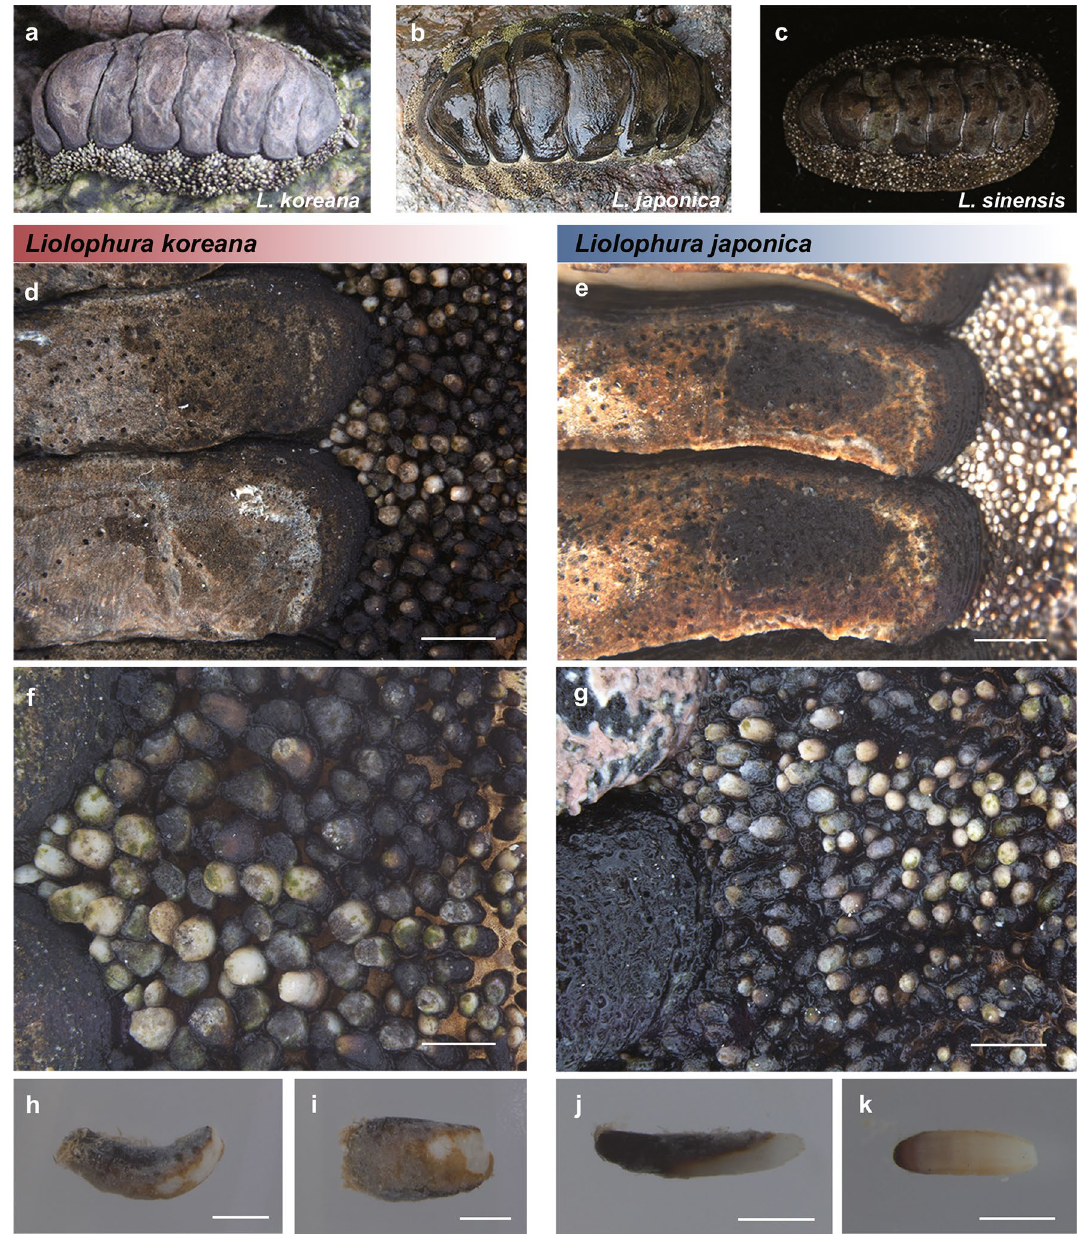
Figure 5. Morphological comparison of Liolophura koreana , sp. nov., L. japonica , and L . sinensis , sp. nov. (a–c) Photos of dorsal views of the individuals belonging to L . koreana (Lineage N), L . japonica (Lineage S1), and L . sinensis (Lineage S2) in order. (d,e) Morphological comparison of pleural and lateral black spots on valves III and IV of the tegmentum of L . koreana (d; holotype) and L . japonica ( e ). (f,g) Morphological comparison of spicules on the perinotum of L . koreana ( f ; holotype) and L . japonica ( g ). (h–k) Morphological comparison of the spicule of L . koreana ( h , i ; paratype) and L . japonica ( j , k ) in lateral and dorsal views. The scale bar marks 2.0 mm ( d , e ), 1.0 mm ( f , g ), and 0.5 mm ( h – k ). The photos were edited using Adobe Photoshop v.22.2 (https:// www. adobe. 75 Ka. This indicated that population expansion had occurred more dramatic in L . koreana than in L . japonica and L . sinensis , following the last interglacial age, called the Eemian (129–116 Ka). As shown in Fig. 8c and Fig. S10, according to the molecular clock analysis by the BEAST program, it was estimated that L . japonica and L . koreana shared their most recent common ancestor about 3.37 Ma, around the mid-Pliocene warm period (3.30–3.00 Ma), before the extensive glaciation in the late Pliocene (ca. 3.00 mya). L . japonica and L . sinensis likely diverged around 1.84 Ma, around the beginning stage of the Early Pleistocene Transition (EPT; 1.85–1.66 mya). The augmentation of haplotype diversity in L . japonica , L . sinensis , and L . koreana might have intensified in the interglacial stages during the late-middle (0.35–0.126 Ma) and late Pleistocene (0.126–0.012 Ma), before the last glacial maximum (LGM: 0.026–0.019 Ma).